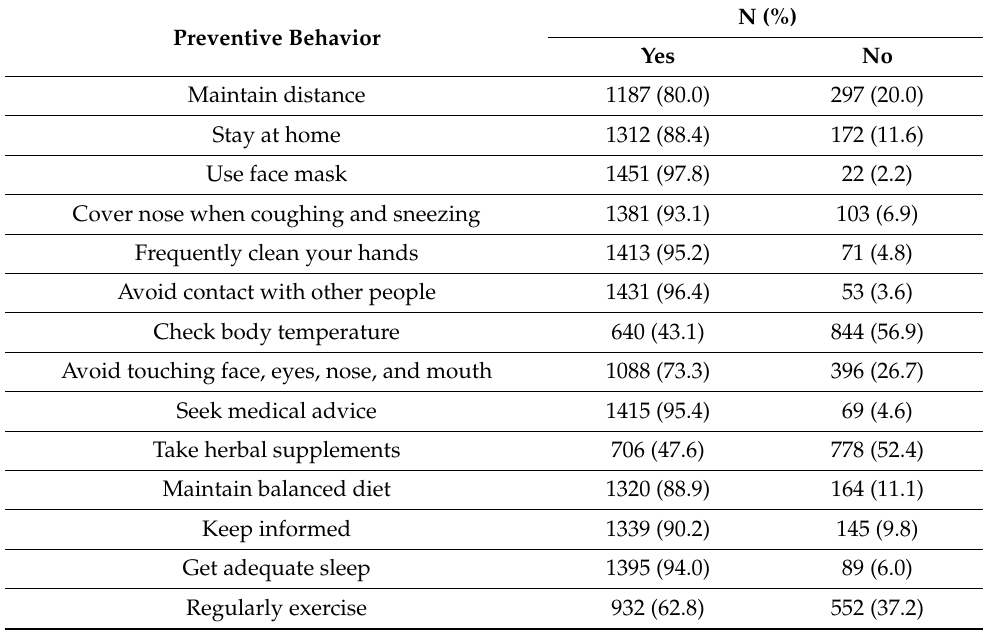
Table 3. Preventive behaviors of Nepalese adults (N =